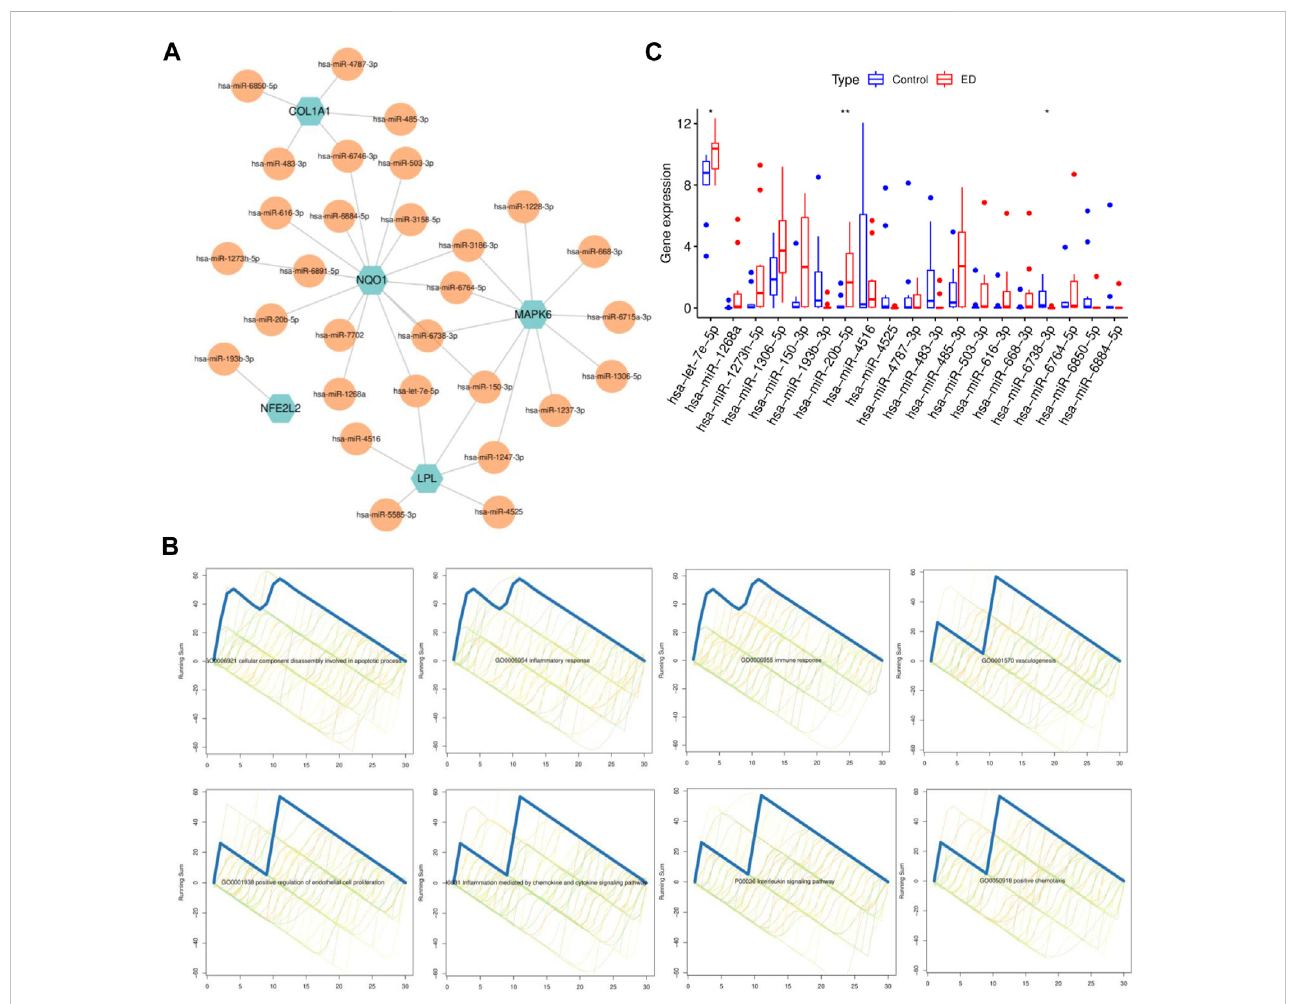
FIGURE 6 MiRNA-CPRGs network construction and functional enrichment analysis. (A) MiRNA-CPRGs co-regulatory network. (B) The functional enrichment analysisofmiRNAs. (C) TheexpressedpatternofmiRNAsbetweenEDandcontrolgroups.For (A) ,greenlabelsrepresentCPRGsandyellowlabelsformiRNAs. CP, chronic prostatitis; CPPS, chronic pelvic pain syndrome; CPRGs, CP/CPPS-related genes; ED, erectile